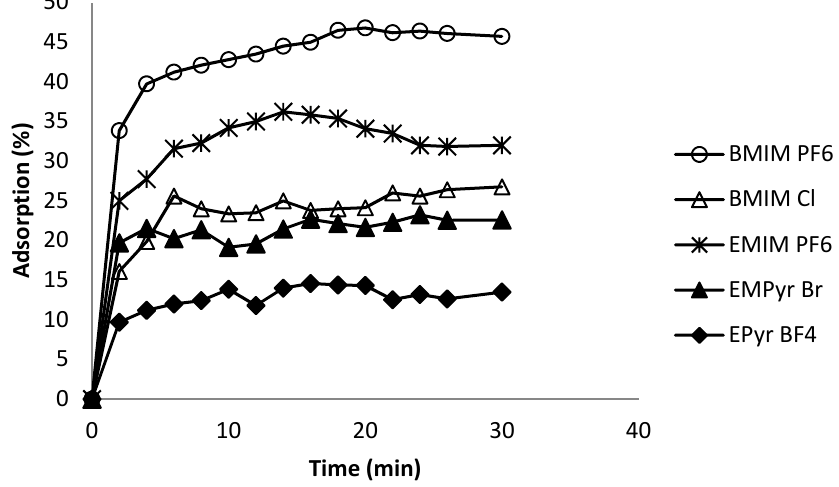
Figure 5. Effect of time on adsorption efficiency.